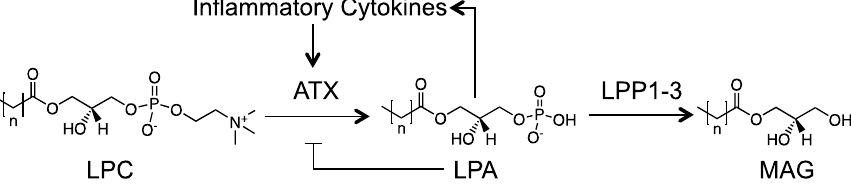
Figure 1. Overview of the lysophosphatidate (LPA) signaling axis. Extracellular LPA is produced from lysophosphatidylcholine (LPC) by the lysophospholipase D activity of autotaxin (ATX).